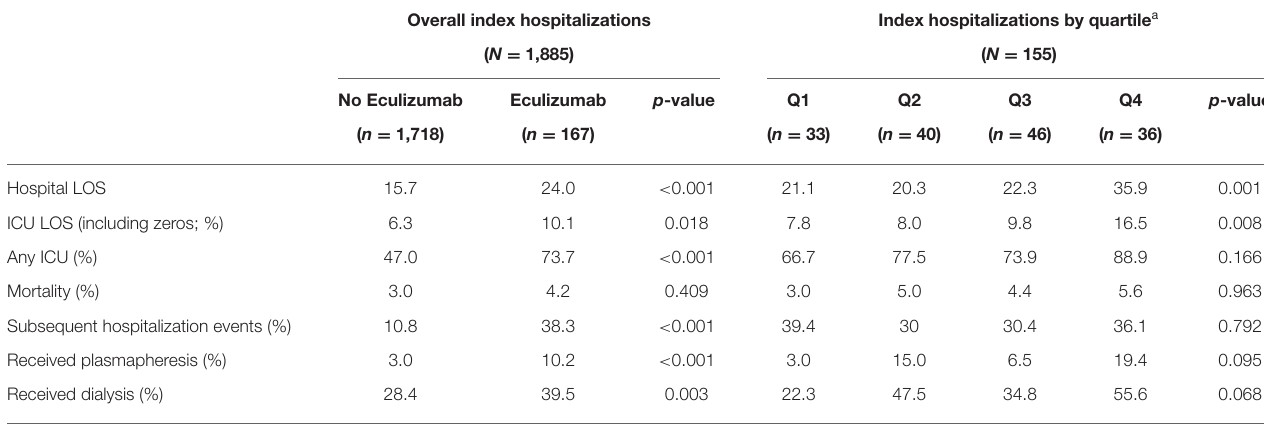
TABLE 2 | Outcomes of index hospitalizations among children with hemolytic uremic syndrome, by administration and timing of eculizumab therapy. Overall index